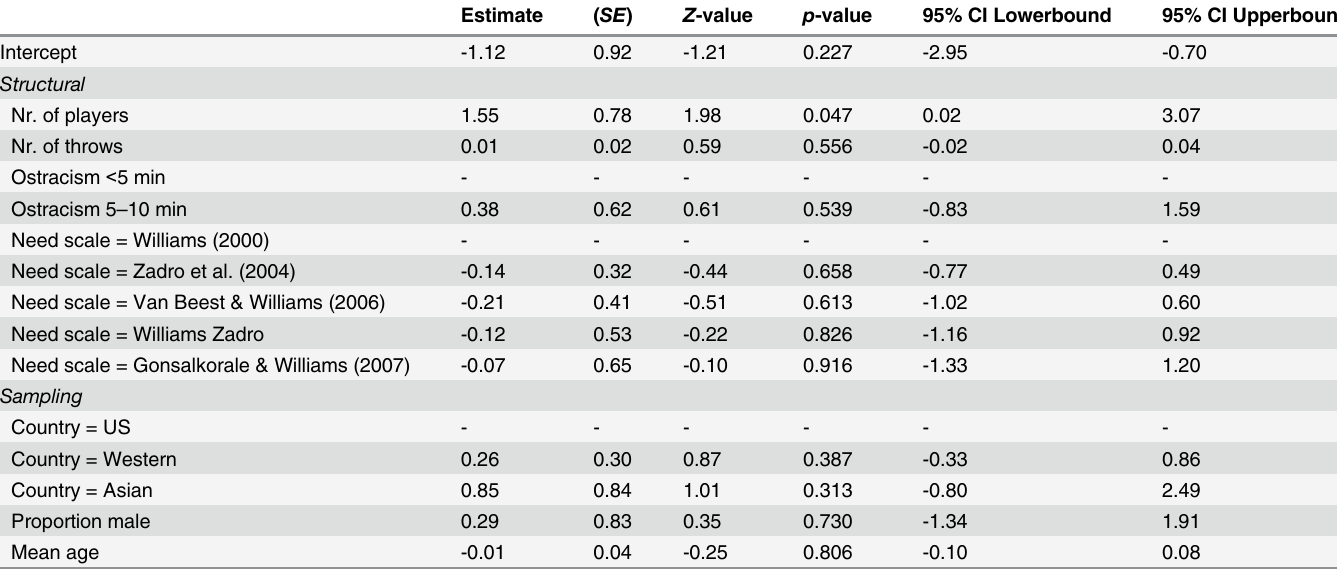
Table 5. Meta-regression coefficients for composition effects (last measure; k =